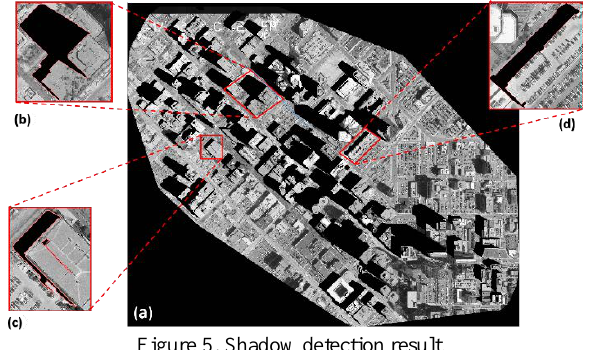
Figure 5. Shadow detection result 4 ．